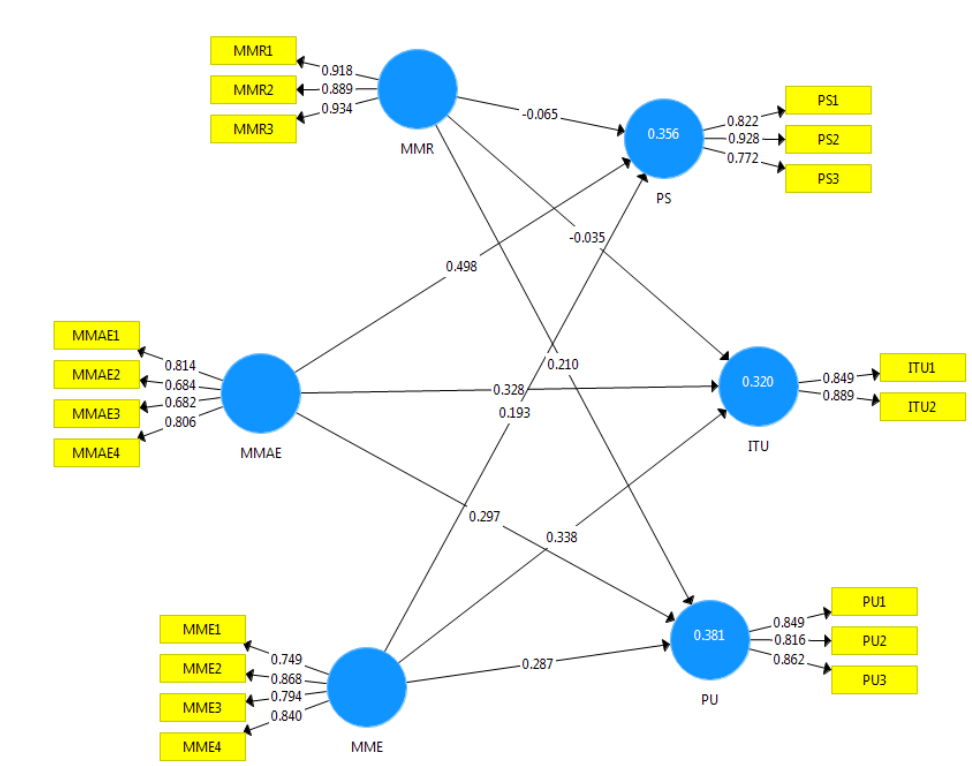
Figure 6. The effect of UDL variables on the model constructs.